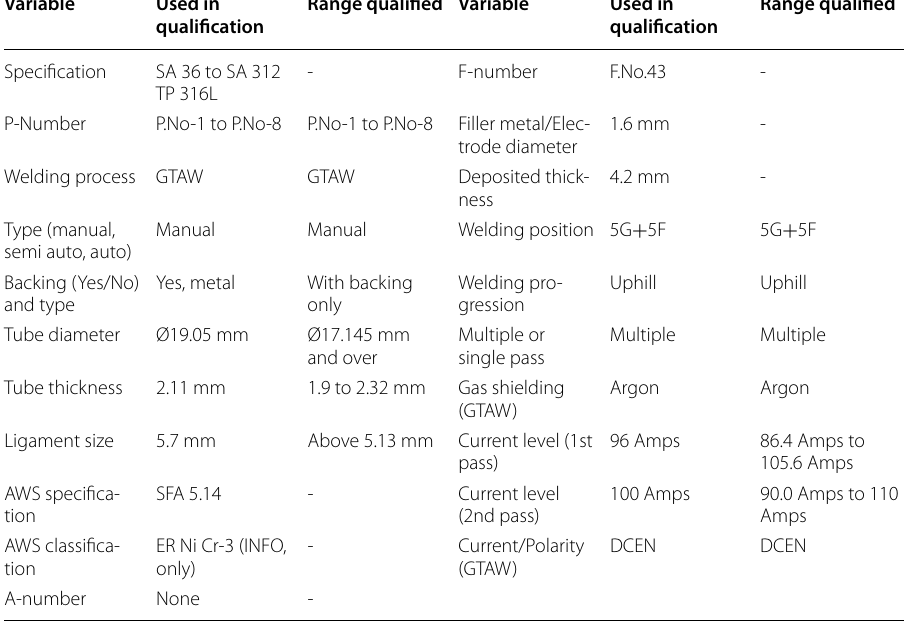
Table 6 Record of actual values